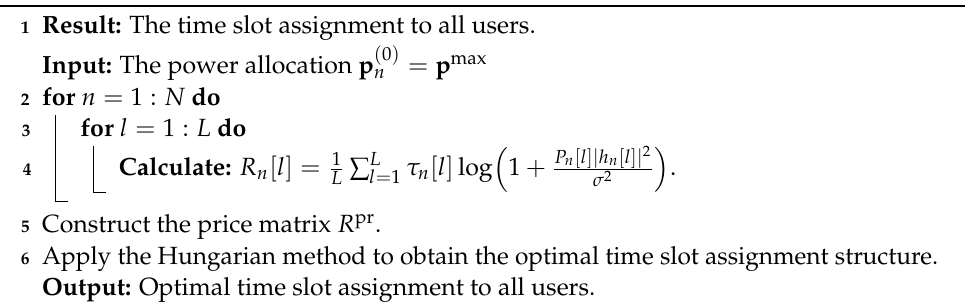
Algorithm 2: Hungarian time slot assignment